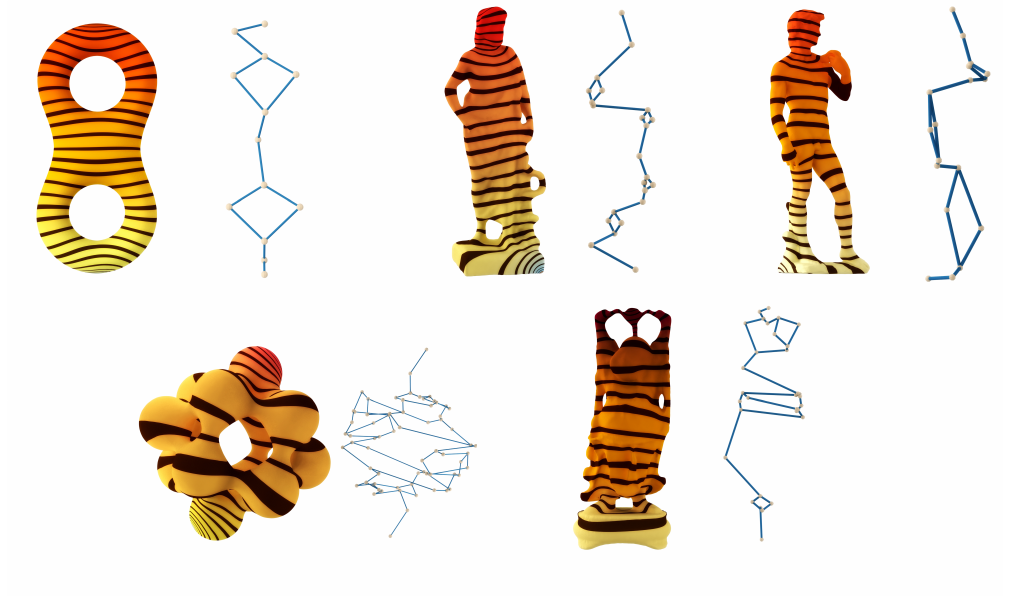
Figure 19. Some of the meshes that we used for our parallel Reeb graph